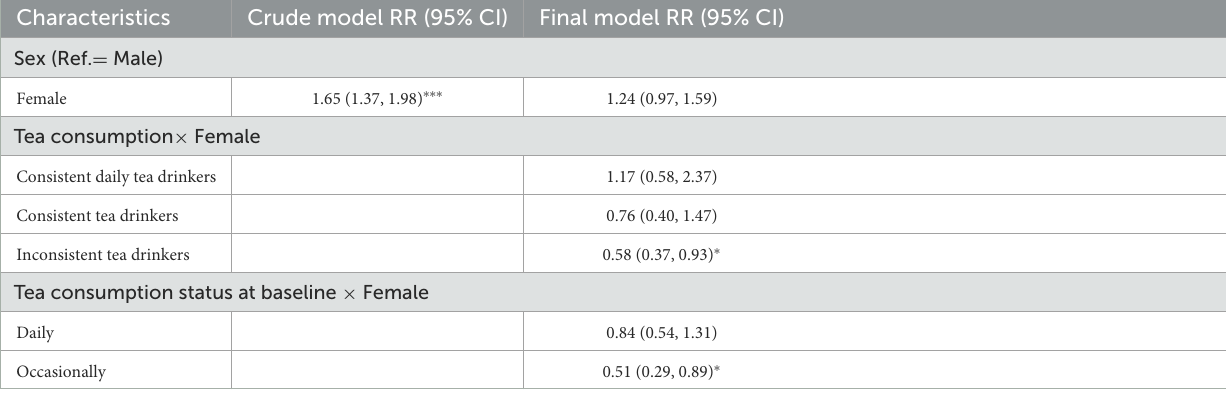
TABLE 4 Effect of interaction between tea consumption and sex on frailty.